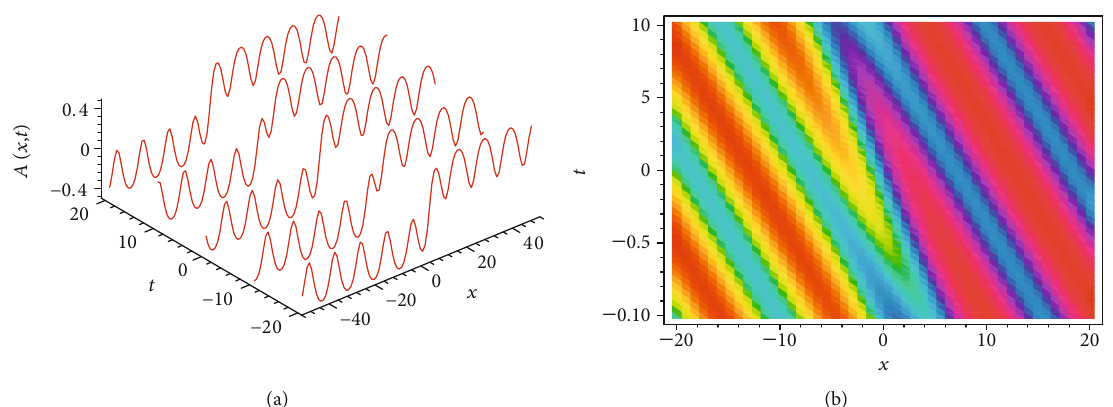
Figure 2: The interaction between kink and cnoidal wave solution for A in equation (76) is shown with the parameter selected as equation (77). (a) is the interaction structure and (b) is the corresponding density